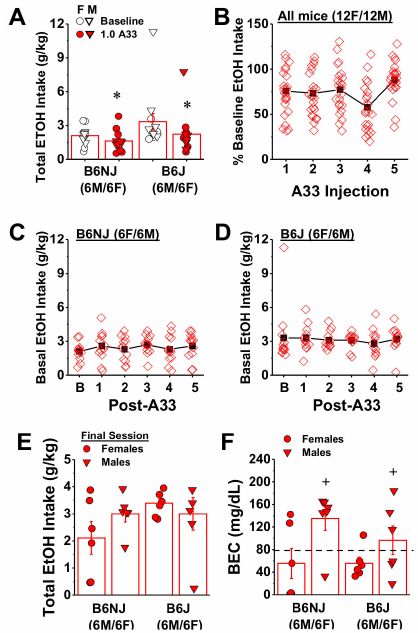
Figure 10. Repeated, intermittent treatment with 1.0 mg/kg A33 reduces alcohol intake under single-bottle DID procedures. ( A ) Comparison of the effects of acute pretreatment (30 min prior) with 1.0 mg/kg of A33 (1.0 A33) upon the intake of 20% alcohol under DID procedures between B6NJ and B6J mice. ( B ) Summary of the effect of repeated, intermittent, pretreatment with 1.0 mg/kg of A33 upon the intake of 20% alcohol by all of the mice in Experiment 2. Note that the data are expressed as a percentage of the average baseline alcohol intake, depicted in Panel A. Comparison of the baseline intake of 20% alcohol prior to A33 treatment ( B ) and the alcohol intake observed on the days between A33 injections in ( C ) B6NJ and ( D ) B6J mice. Comparison of the alcohol intake exhibited by female and male B6NJ and B6J mice on the final drinking day prior to blood collection ( E ) and their resultant BECs ( F ). The data represent the mean ± SEM of the number of mice indicated, in addition to the individual data points for each experimental group. * p < 0.05 vs. Baseline (main effect); + vs. Females (main